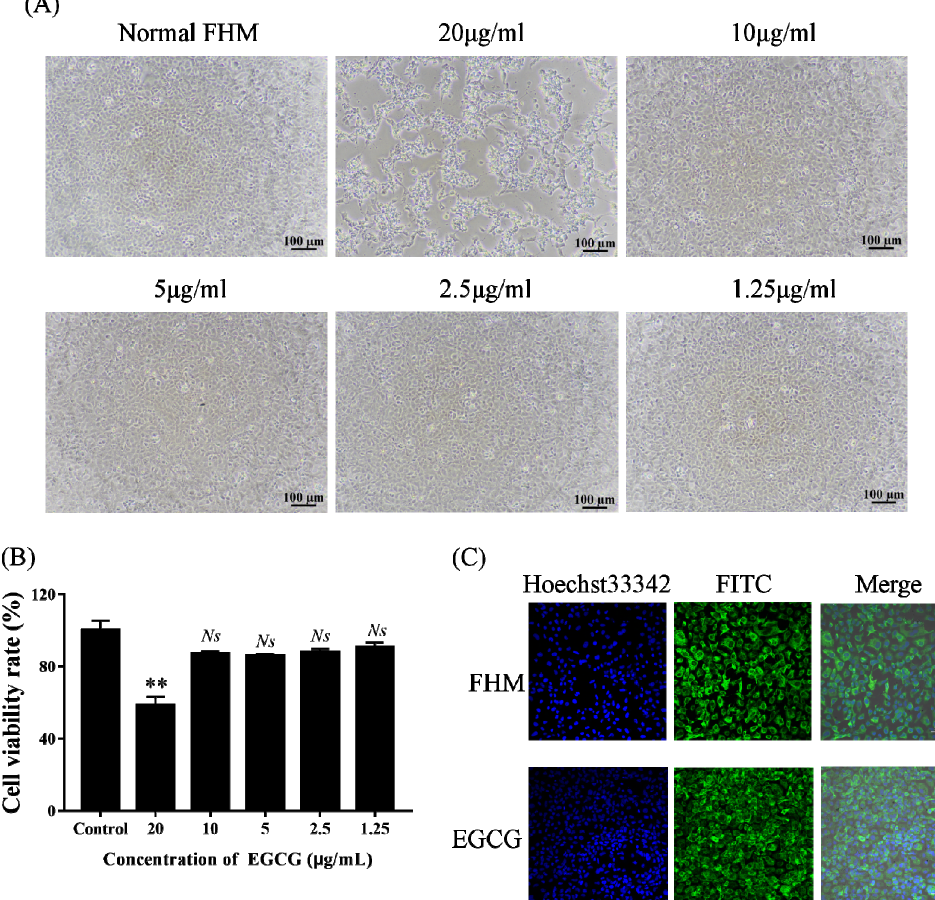
Figure 1. Safe concentration of EGCG. ( A ) The morphological changes of FHM cells incubated with different concentrations of EGCG were observed by light microscopy. Pathological morphological changes, including rounding, shrinking, and detachment from the culture plate, were not detected in FHM cells incubated with EGCG at concentrations of 10 µ g/mL or lower. Scale bar indicates 100 µ m. ( B ) CCK-8 was used to detect cell viability of EGCG-treated FHM cells. The viabilities of cells cultured with 1.25–10 µ g/mL EGCG were the same as those of the control cells, illustrating that EGCG ≤ 10 µ g/mL had no significant cytotoxic effects on FHM cell viability. (** p < 0.01; NS , no significant difference). The same below. ( C ) Fluorescein isothiocyanate-labeled anti-cytokeratin antibodies were applied to observe the cytoskeleton. Compared with cells in the control group, the cytoskeleton of cells incubated with EGCG (10 µ g/mL) was kept normal. Scale bar: 50 µ m.